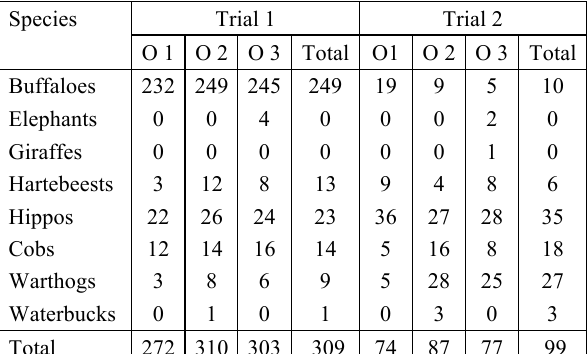
list, ii) switch between observers to see what they missed,